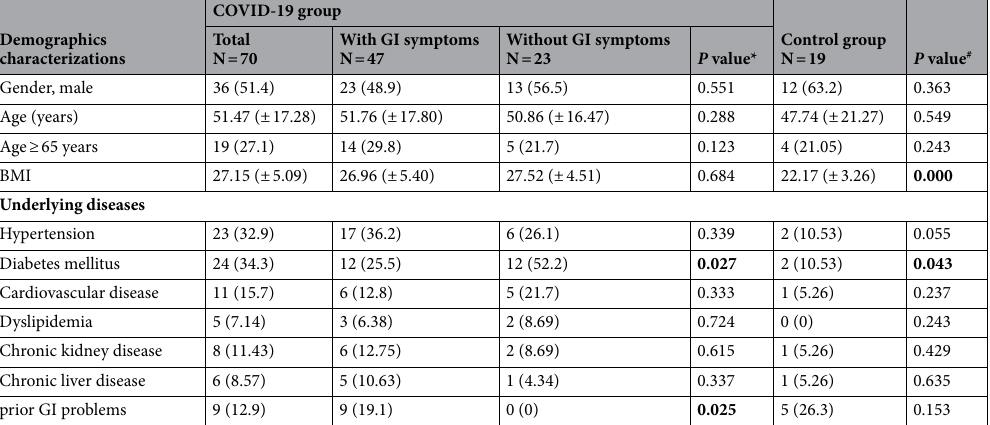
Table 1. Demographic characteristics of COVID-19 patients and healthy individuals. Data are shown as frequency (percentage). *COVID-19 patients with GI sign vs. no GI sign. # COVID-19 patients vs. control. Bold text indicates P values < 0.05.